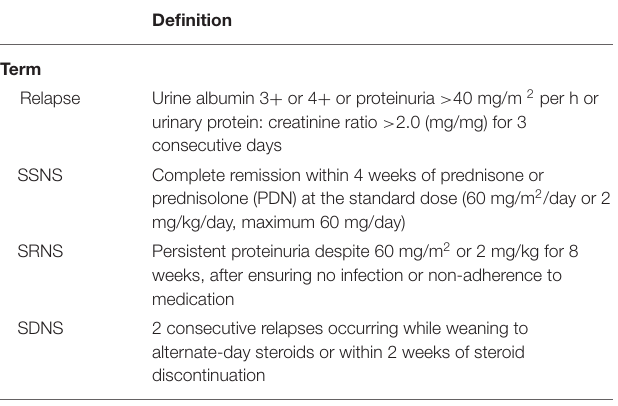
TABLE 1 | Relevant definitions in nephrotic syndrome.